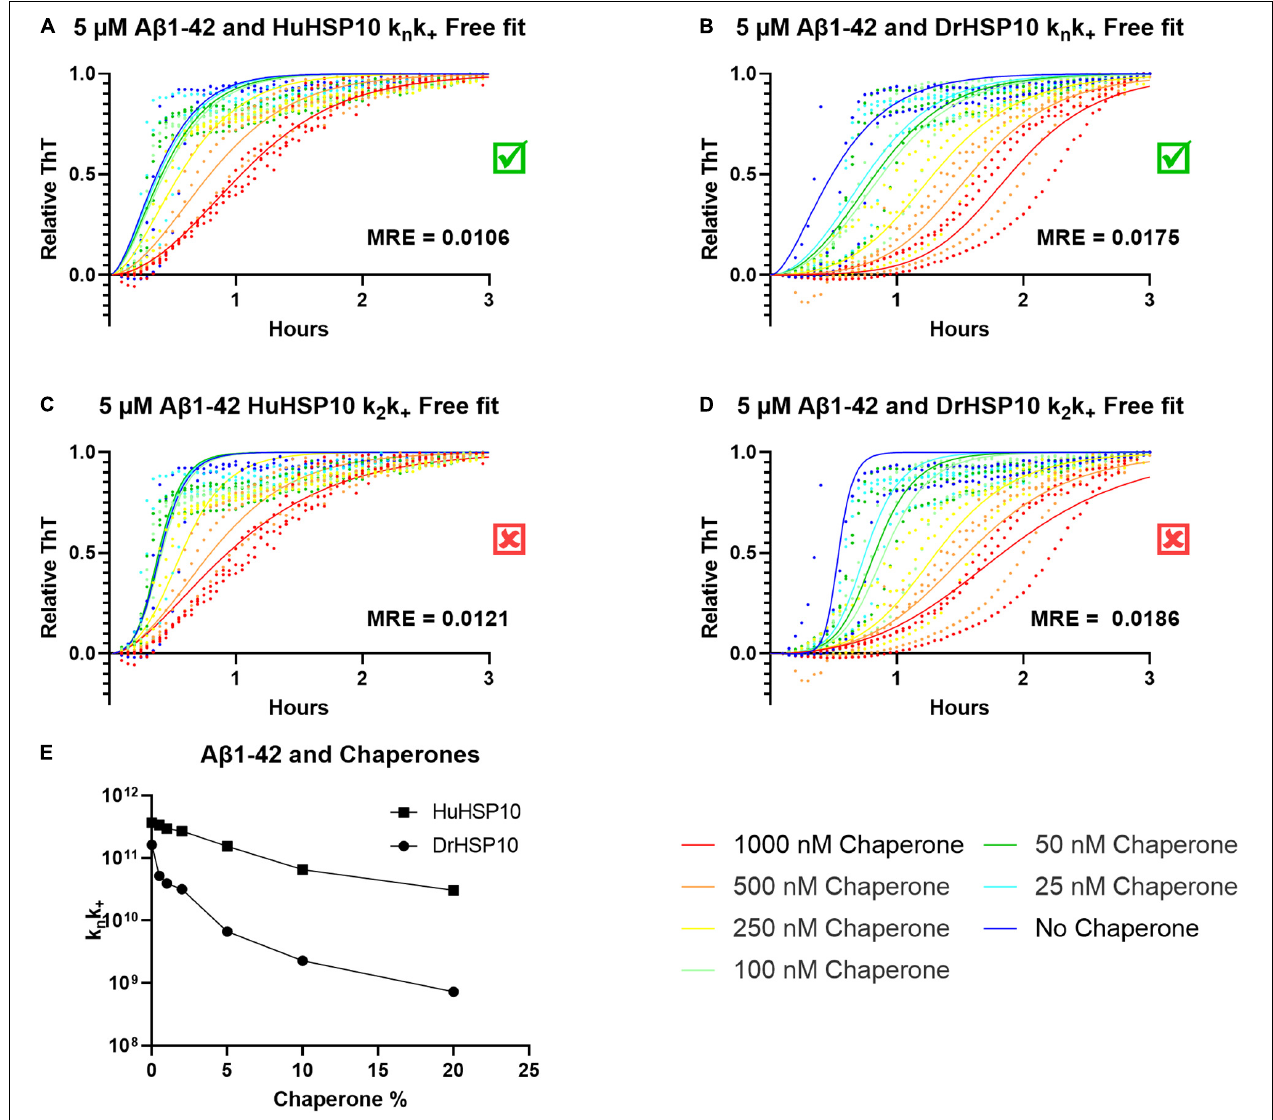
FIGURE 8 | ThT kinetics for 5 µ M A β 1–42 with the chaperones HuHSP10 and DrHSP10 present at various concentrations with model curves fitted using Amylofit. (A,C) Fitted data for HuHSP10, (B,D) fitted data for DrHSP10. Both chaperones fit best to free fitting parameters k n k + , as shown by mean squared residual error (MRE) of the global fits, i.e., chaperones were mostly affecting primary nucleation and elongation and worse fits for secondary nucleation (k 2 ) and elongation. (E) k n k + , as a function of substoichiometric chaperone concentration, to compare HuHSP10 and DrHSP10, respectively. DrHSP10 was more efficient than HuHSP10 in suppression of fibrillation of A β 1–42. Each dot represents an average of four replicates; the assay was repeated three times in a 96 well non-binding